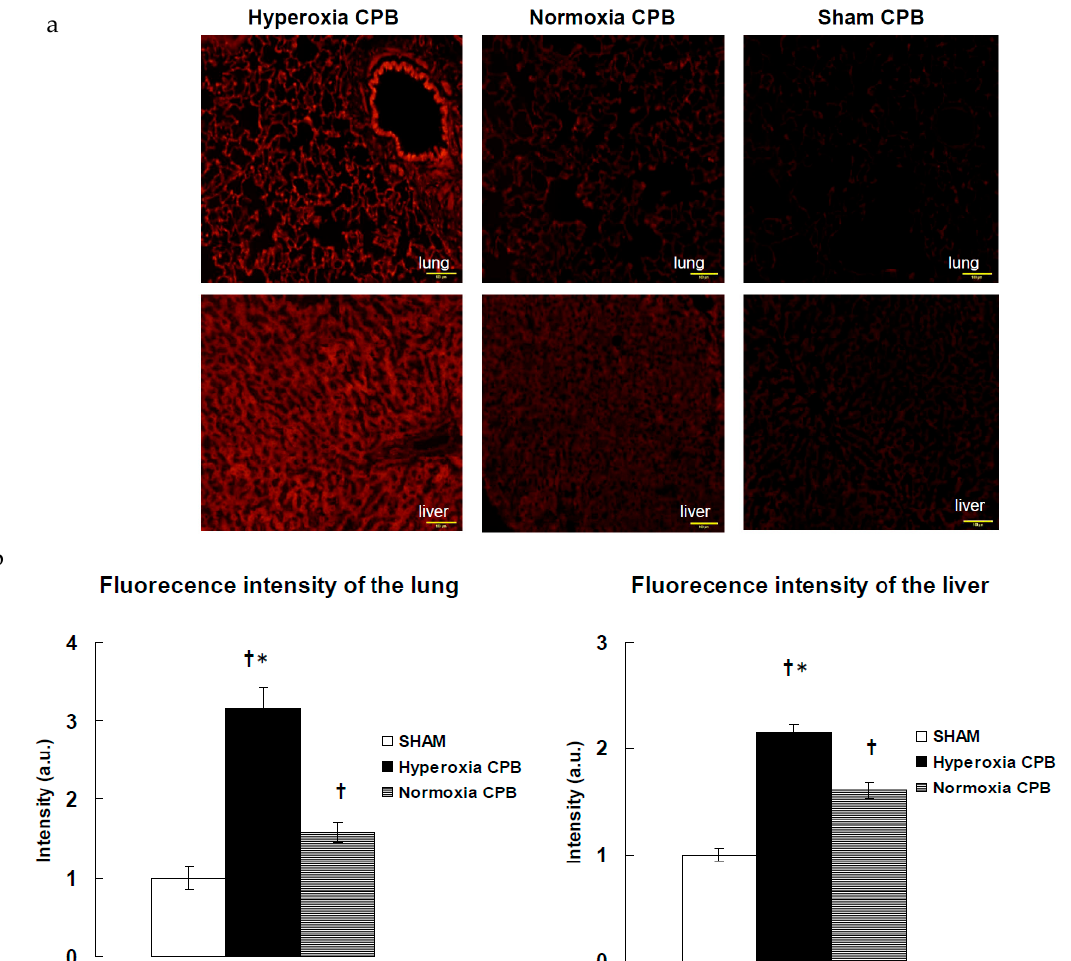
Figure 4. The wet-to-dry weight (W/D) ratio of the lung at the end of experiment [25] . † p < 0.05 versus the SHAM group, * p < 0.05 versus the Normoxia CPB group.